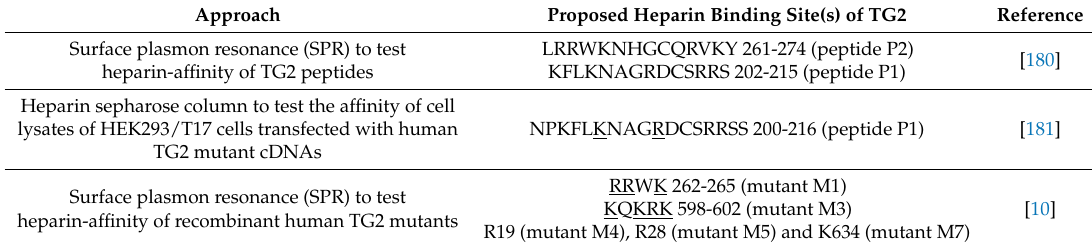
Table 2. Different approaches used for mapping the transglutaminase-2 (TG2) heparin binding site(s). Key amino acids investigated by site directed mutagenesis [10,181] are